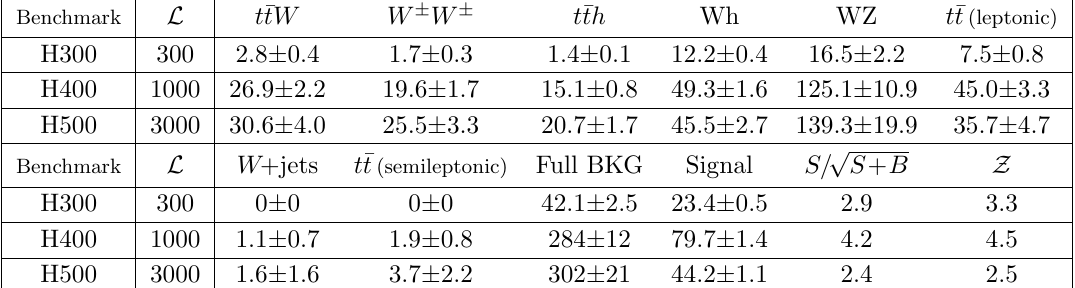
Table 5 . BDT optimization in the same-sign di-lepton (SS2L) channel for the three benchmarks with di(cid:11)erent integrated luminosity L (in the unit of fb (cid:0) 1 ). We present, after the optimal BDT cuts, the selected event numbers for the signals, backgrounds, and median signi(cid:12)cance Z .